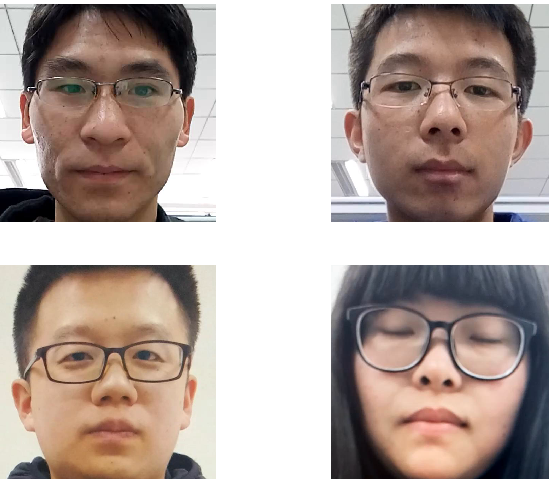
Figure 1. Samples of bonafide and spoofed images from the OULU-NPU [14] dataset, which illumi- nate the difficulty of visually discerning the two classes. The two images on the first row represent the bonafide samples, and the second row represents two spoofed